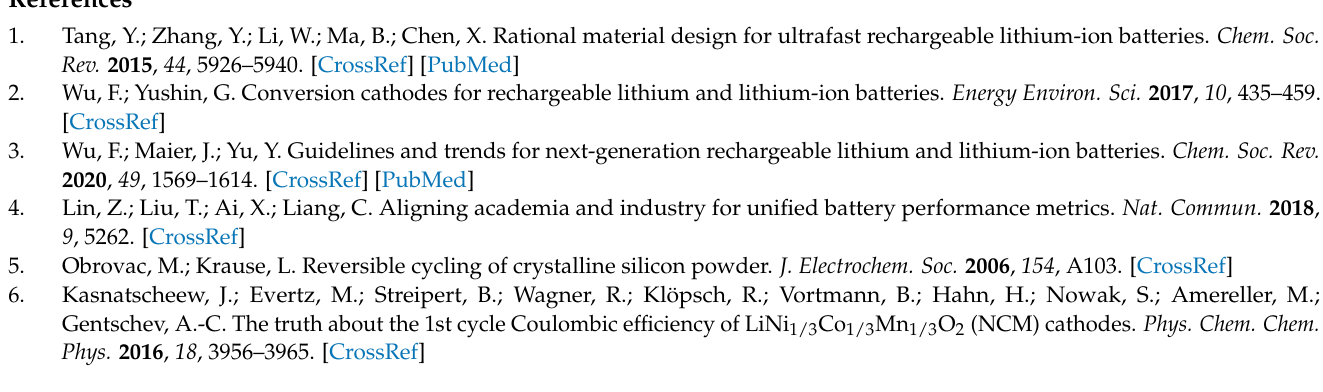
Figure S1: Comparison of (a) 1st charge/discharge profiles (b) coulombic efficiency of the 4 samples half-cell; Figure S2: Comparison of (a) 1st charge/discharge profiles (b) coulombic efficiency of the 4 samples full-cell; Table S2: Initial coulombic efficiency values in Figures 3c and 4a; Figure S3: Charge/discharge curves at various current density of (a) CB1 (b) Hybrid1 (c) Hybrid2 (d) SW0.05; Figure S4: (a) GITT curves for 4 samples. (b) Detailed GITT curves from 1200 to 2400 s at 0.5C; Table S3: Detailed values of Li ion diffusion coefficient; Figure S5: Resistance vs. SOC profiles during the charge; Table S4: Detailed values at various